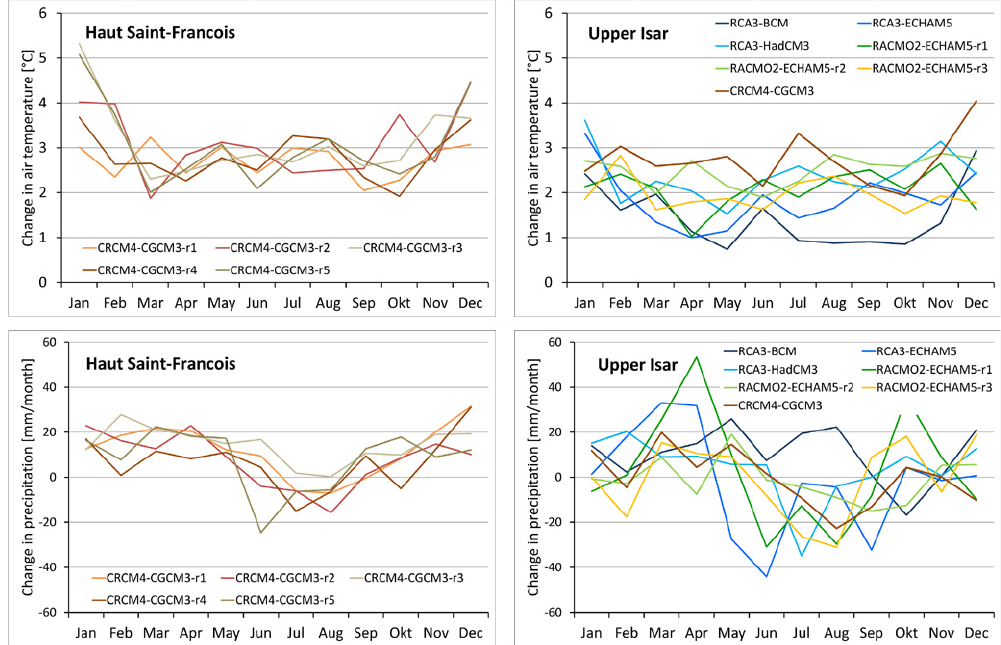
Fig. 4. Climate change signal of air temperature (upper panels) and precipitation (lower panels) over the two main catchments Haut-Saint- Franc¸ois (left panels) and Upper Isar (right panels) between the reference (1971–2000) and the future (2041–2070) period. (Acronyms refer to RCM–GCM combinations and runs in a GCM member ensemble.) Table 2. Characteristics of the hydrological model